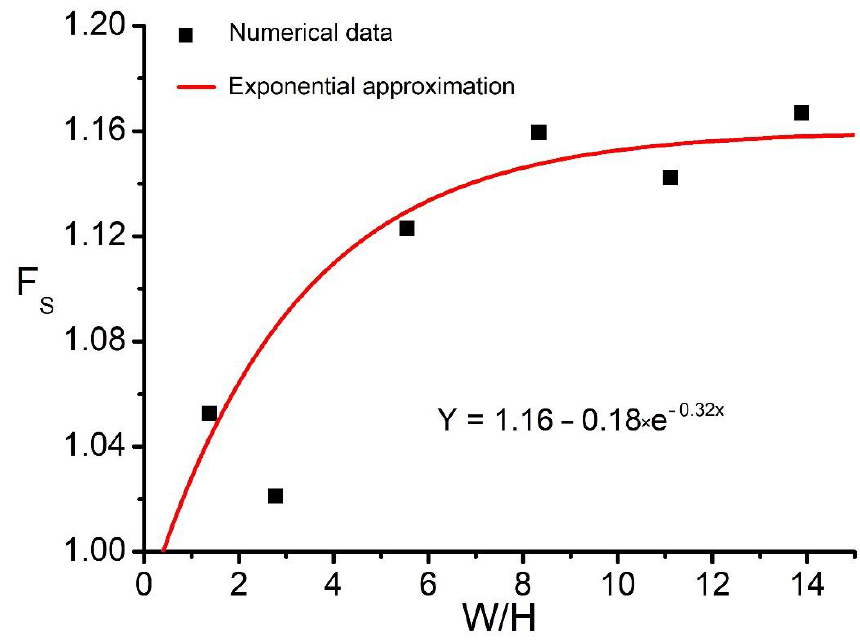
Figure 10. Dependence of s F on / W H ratio averaged in the protective pillar volume.